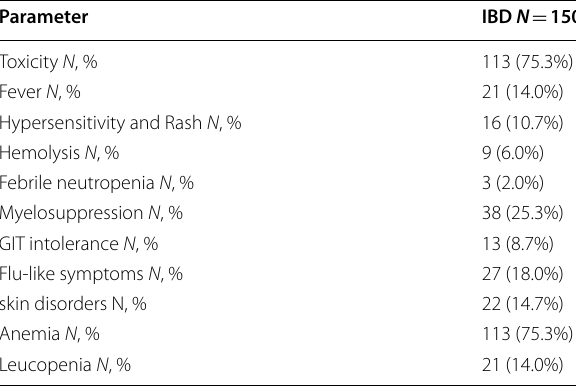
Table 2 Frequency of treatment